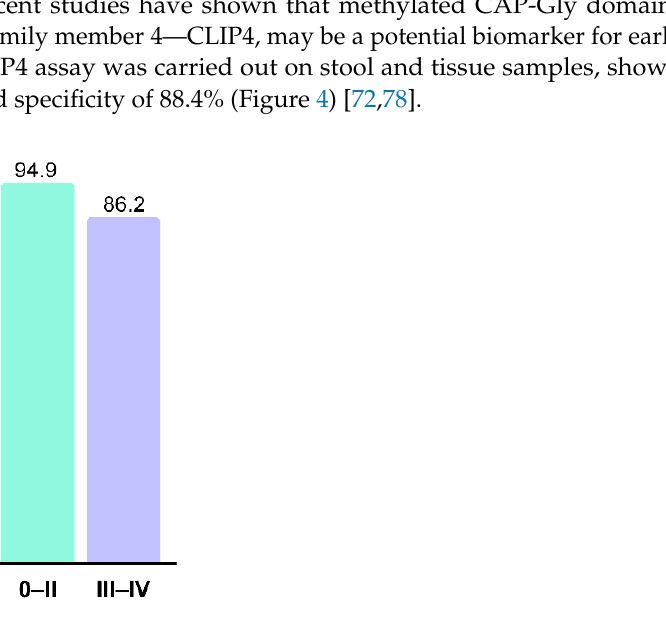
Figure 4. Sensitivities of stool mCLIP4 test in detecting different CRC stages (after Cao et al., 2021) [72].